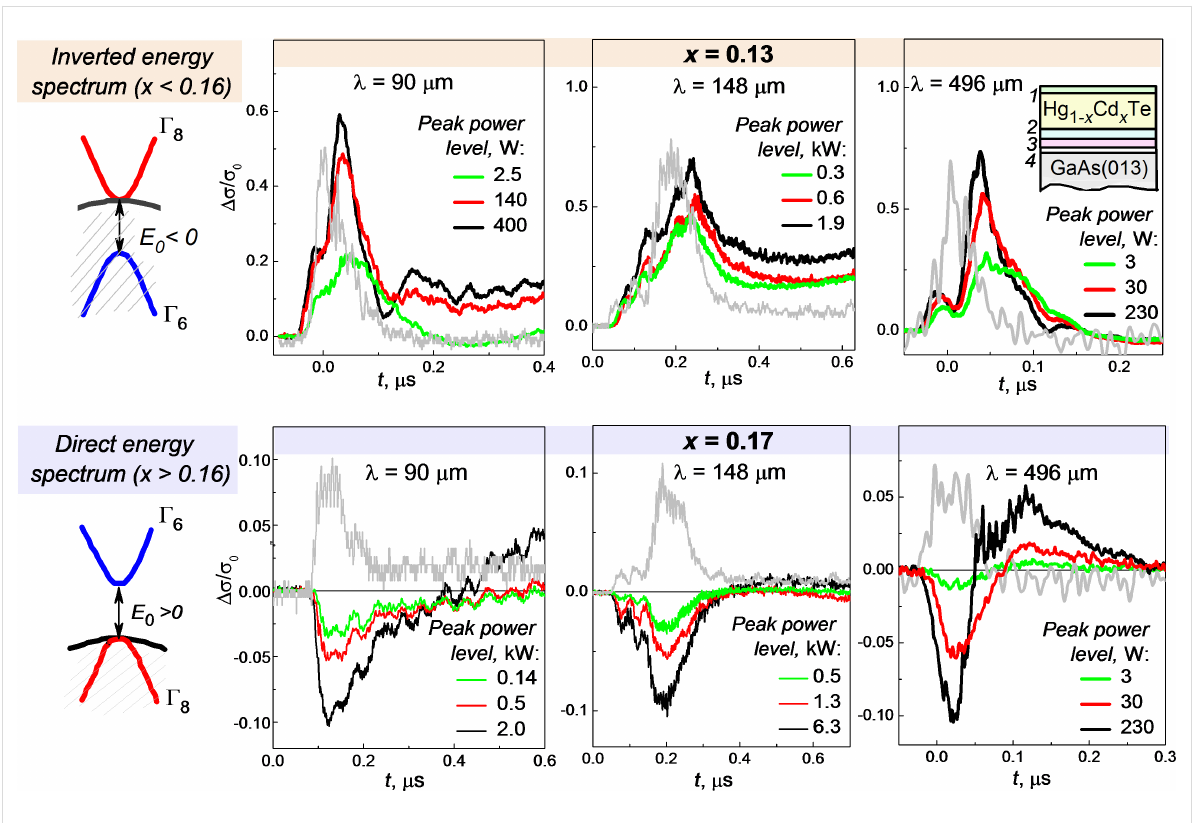
Figure 1: Photoconductivity kinetics Δσ / σ 0 in Hg 1 − x Cd x Te films with x = 0.13 (the upper panel) and x = 0.17 (the lower panel) at the wavelengths λ = 90; 148; 496 µm for various radiation peak power levels. The laser pulse time profiles are shown by grey lines. The energy band structure for both solid solutions is shown schematically to the left of the plots. The heterostructure layers are outlined in the right upper corner. The cap and relaxed Hg 1 − y Cd y Te, buffer CdTe and ZnTe layers are indicated by the numbers from 1 to 4,